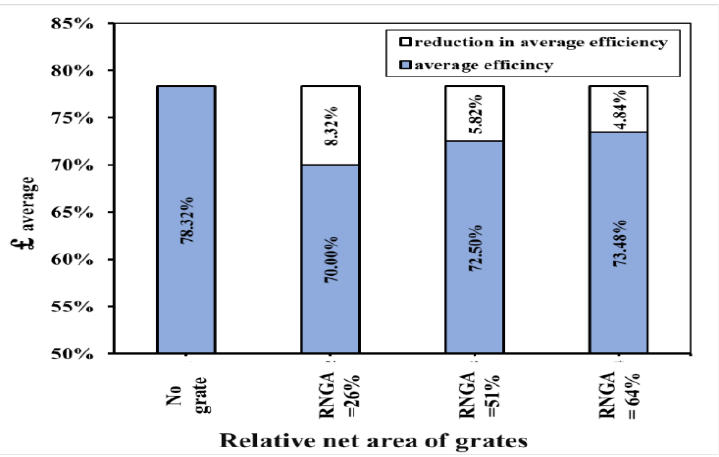
Figure 11. The average efficiency of discharge for different inlet area of grates. Table 2. The effect of using different inlet area of on the discharge efficiency.